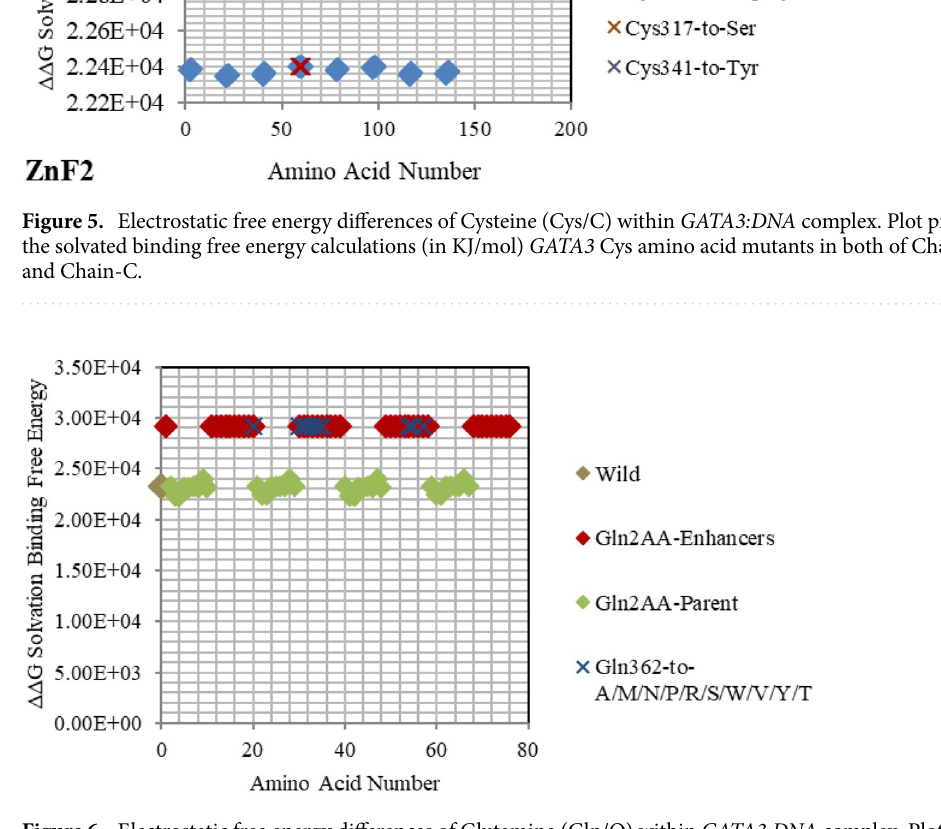
Figure 6. Electrostatic free energy differences of Glutamine (Gln/Q) within GATA3:DNA complex. Plot presents the solvated binding free energy calculations (in KJ/mol) GATA3 Gln amino acid mutants in both of Chain-D and